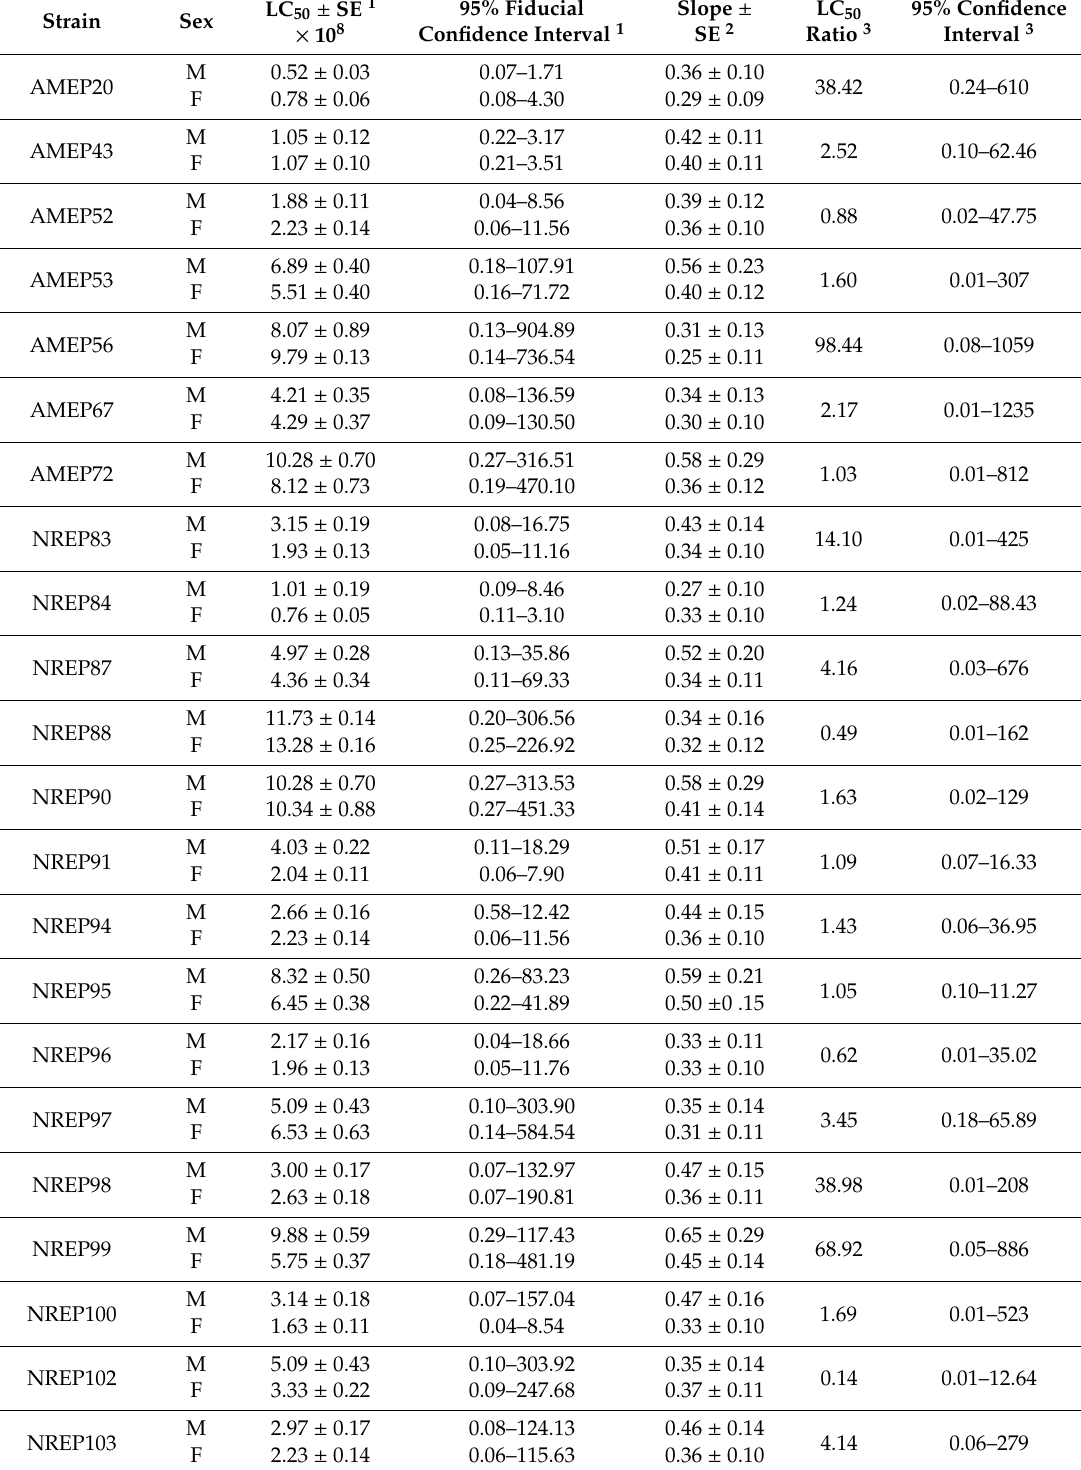
Table 2. Summary of probit analysis parameters from the virulence bioassays performed with Beauveria spp. strains against males (M) and females (F) of Hylobius abietis in